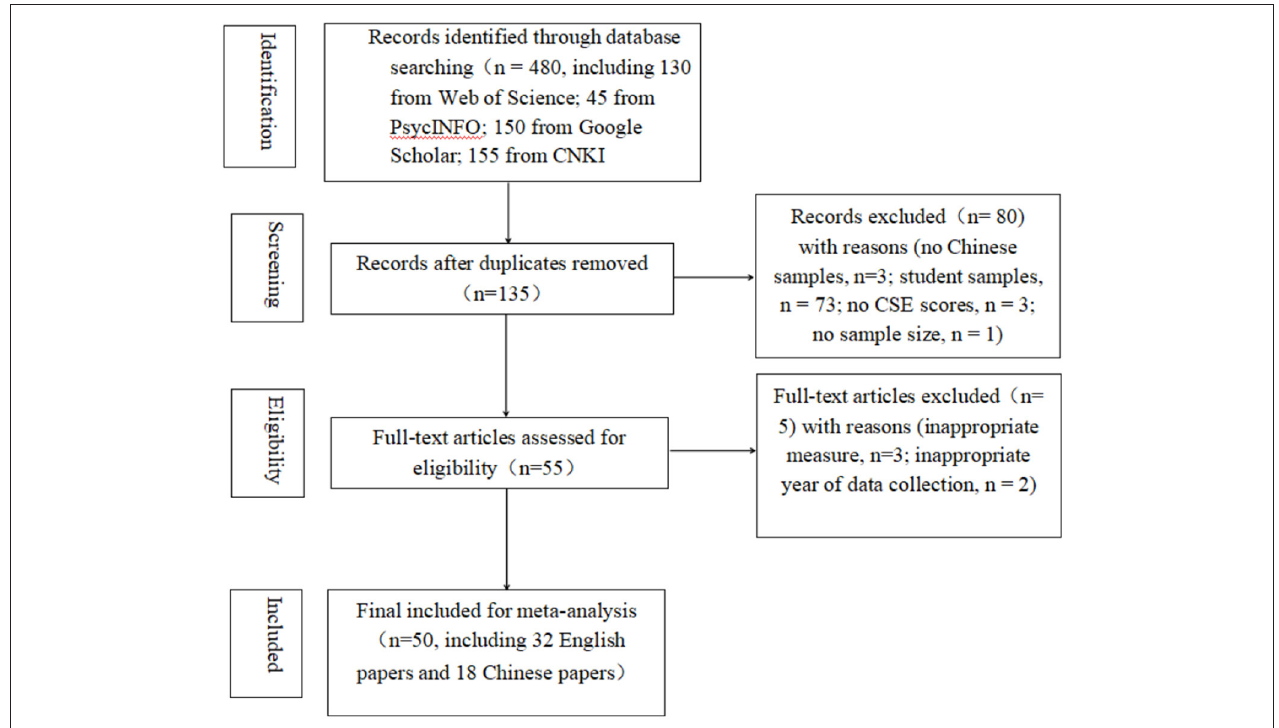
FIGURE 1 | PRISMA